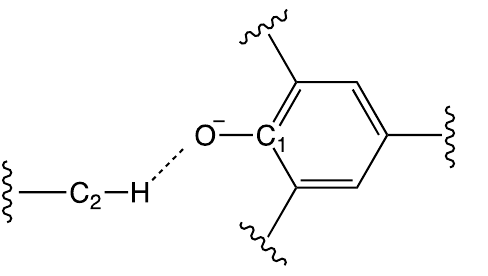
Figure 4. Definition of the labels used in Table 1. C1 represents the carbon atom of Reichardt’s Dye that is bonded to the oxygen O; C2 represents the carbon atom in α position with respect to the positive center nearest to the dye; and H represents the hydrogen atom bound to C2 nearest to the dye. Table 1. Some geometric quantities related to cation- Reichardt’s dye 1:1 complexes.